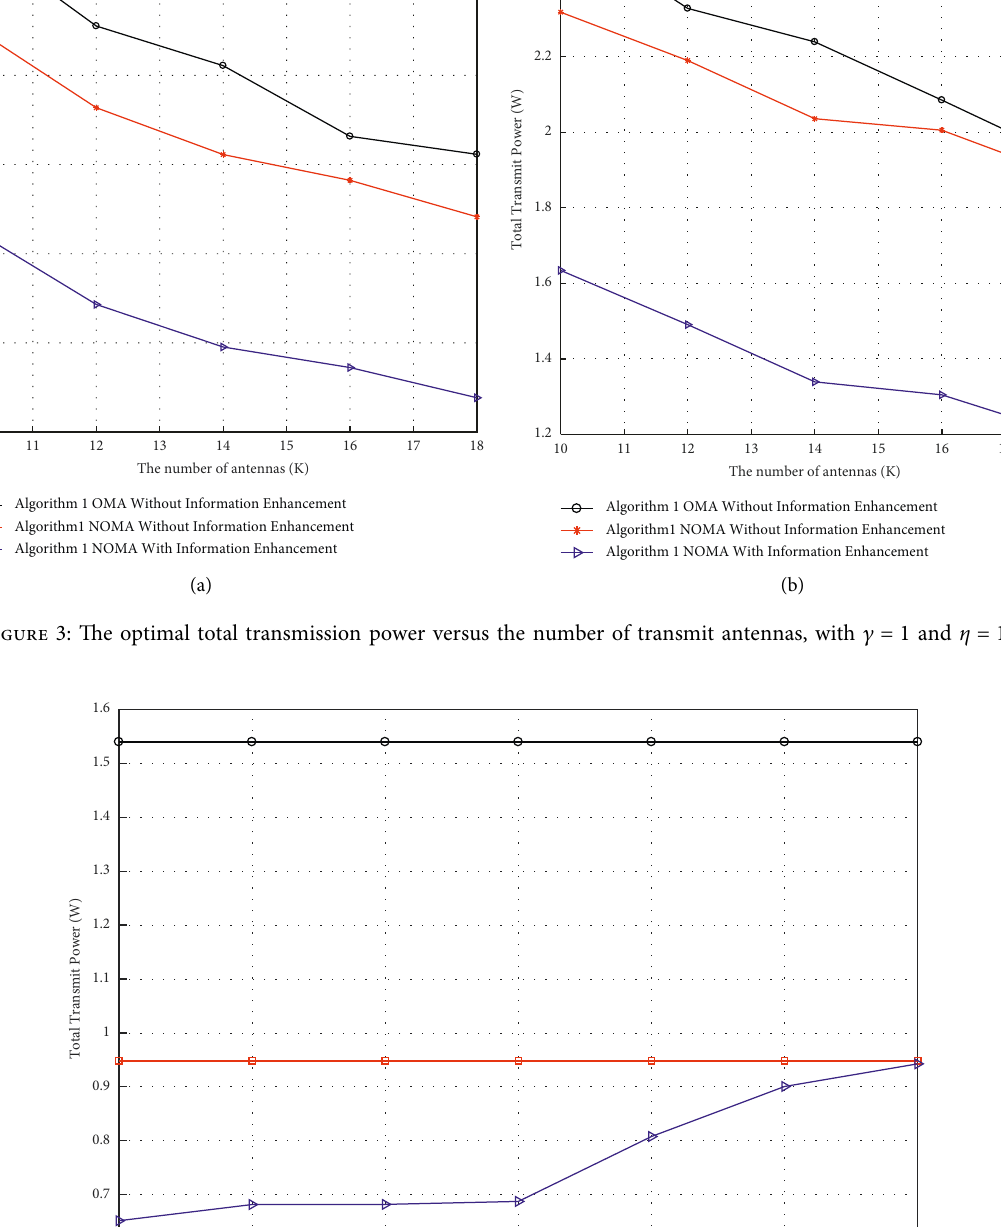
Figure 4: The optimal total transmission power versus the distance between the center user and the edge user, with c � 1 , η � 0 and K �